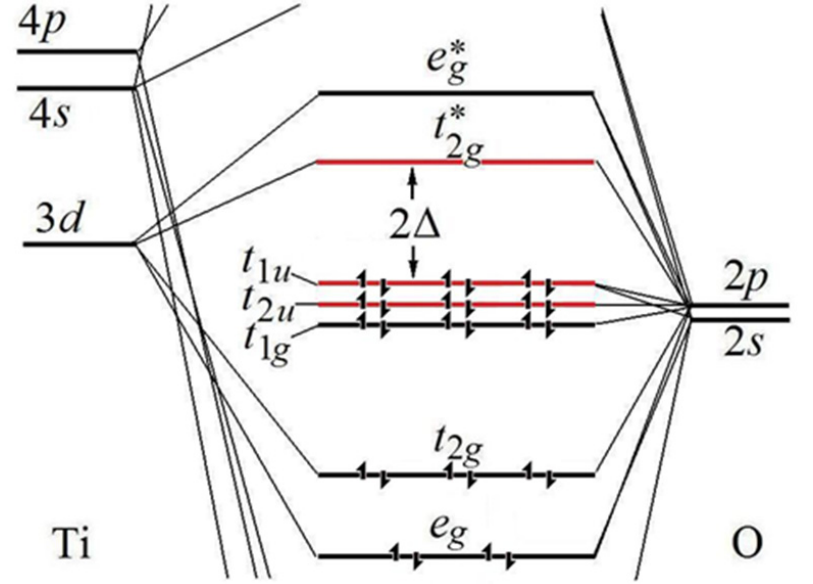
Figure 2. The MO energy-level correlation diagram (not to scale) for the octahedral cluster [TiO 6 ]. HOMO t 1u and t 2u (a combination of mostly oxygen atomic orbitals) and LUMO t 2g (mostly titanium orbitals) are one-electron energy levels of the electronic states that are mixed in the PJTE. The shown electron population of the MOs corresponds to the particular case of [TiO 6 ] 8 − (stars indicate excited states) [4,5,7,8].